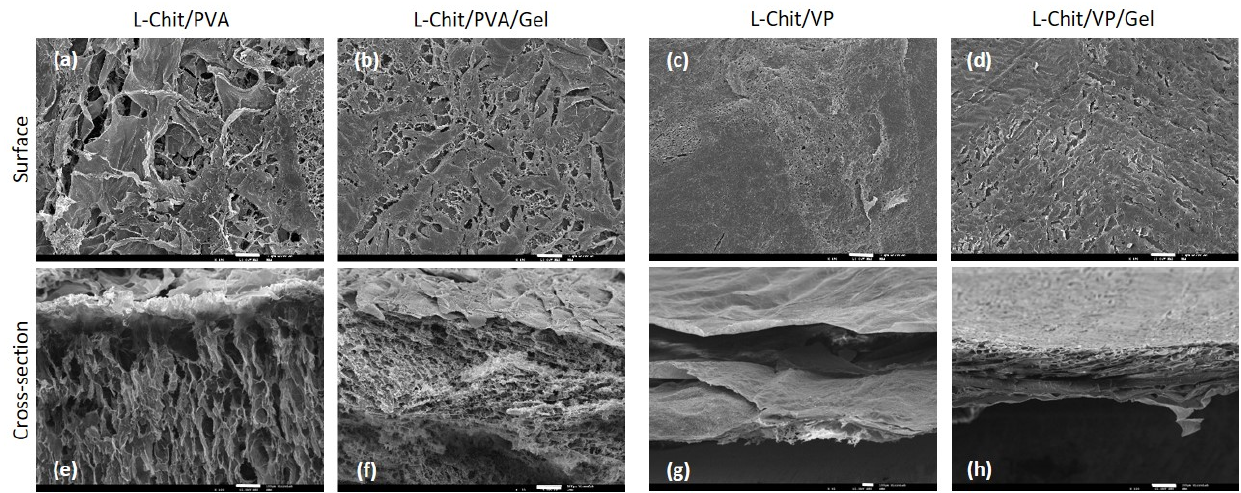
Figure 3. SEM images of the low-Mw chitosan-based membranes γ -irradiated at 10 kGy (scale bar 100 μ m and magnification 100×): ( a – d ) Membranes’ surface; ( e – h ) membranes’ cross-section.